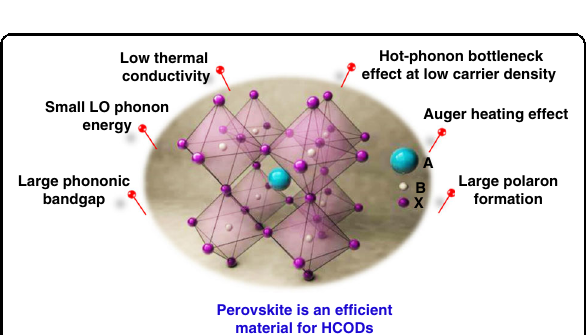
Fig. 7 Organic-inorganic halide perovskite emerge as promising material with outstanding hot carrier properties. The fi gure shows various properties favorable for designing ef fi cient hot carrier optoelectronic devices